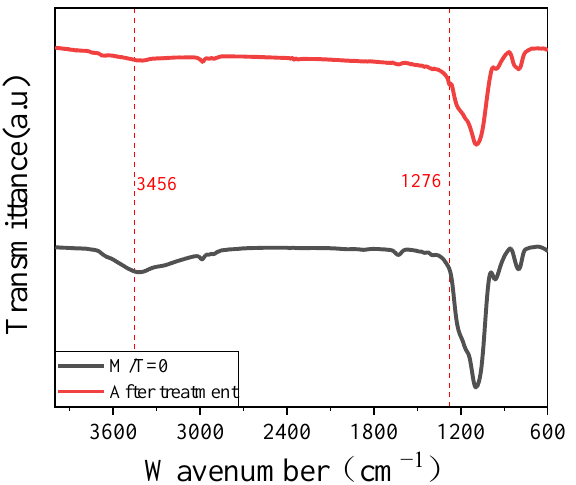
Figure 6. The FTIR spectra of unmodified (M/T = 0) film and the film after MTES/NH 3 vapor treat-